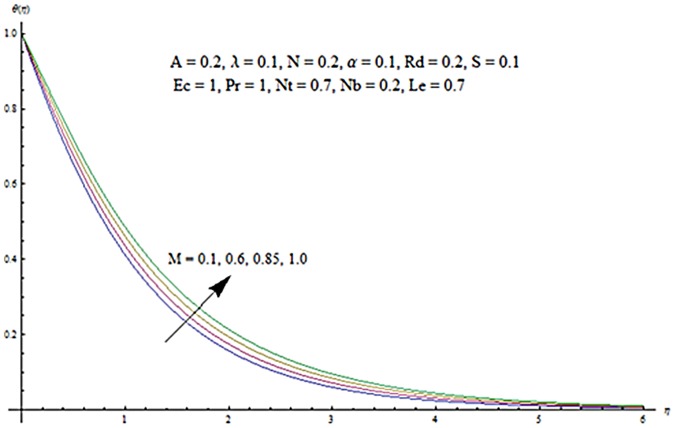
Influence of M on θ.